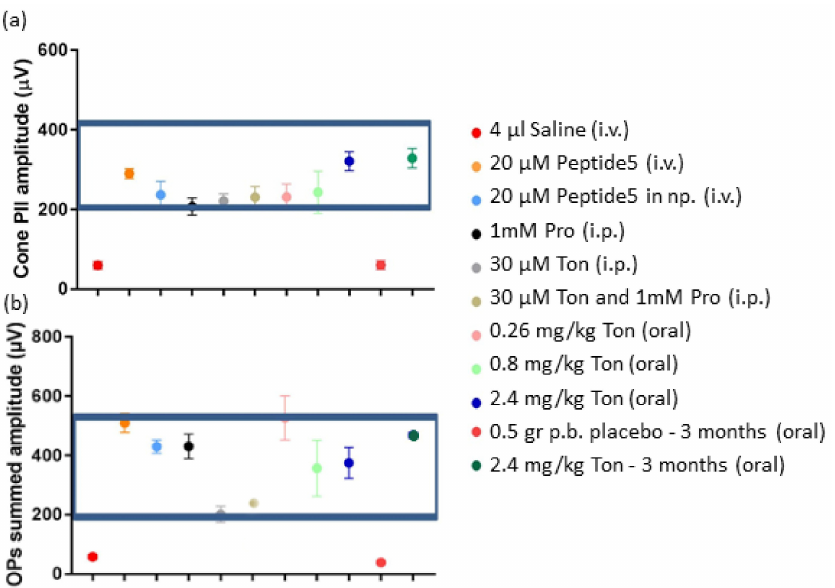
Figure 7. Overall analysis of rod PIII amplitude ( a ) and rod PII amplitude ( b ) for each of the connexin and pannexin treatments applied. in general, the rod photoreceptor response was better with tonabersat and Peptide5 treatments, and the lowest response was from the intervention using probenecid. The rod bipolar cell response (PII) was better with all treatments. Statistical analysis was conducted using one-way ANOVA, followed by a post-hoc test comparing computer-generated normal ERG values with treatment values. The normality values were randomly selected between 400 to 700 µ V for the rod PIII amplitude, and between 400 to 800 µ V for the rod PII amplitude. The boxed area shows treatments that preserved retinal function and were non-significantly different from normal values. Abbreviations as in Figure 6.